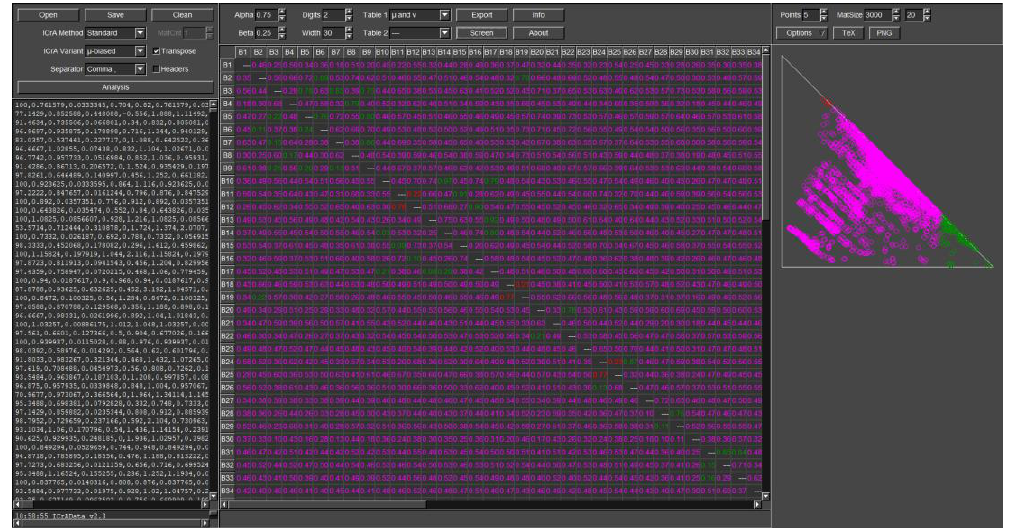
Figure 5. Result of the application of ICrAData v.2.3 over the 88 ECG criteria described in Section 2.1.